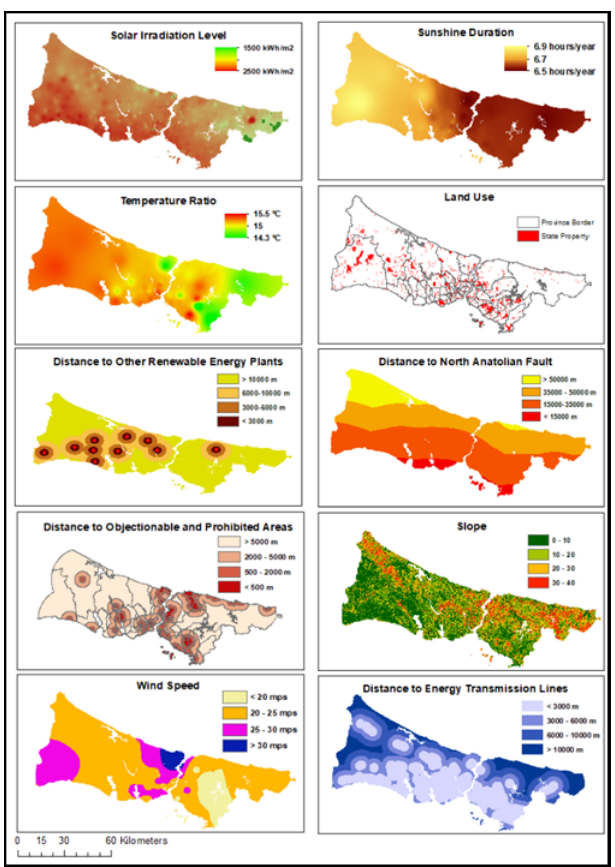
Figure 9. Weighted Criteria Maps